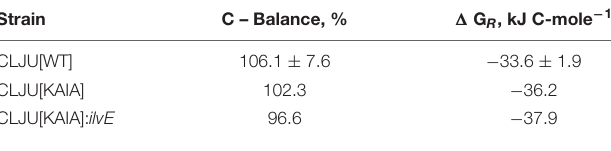
TABLE 3 | Carbon balances and Gibb’s free reaction energies of the syngas-based batch cultivations of the different C. ljungdahlii strains in